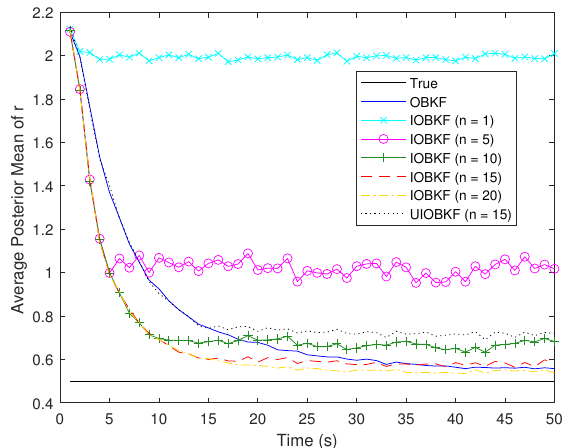
Figure 6. Estimation of noise parameter r